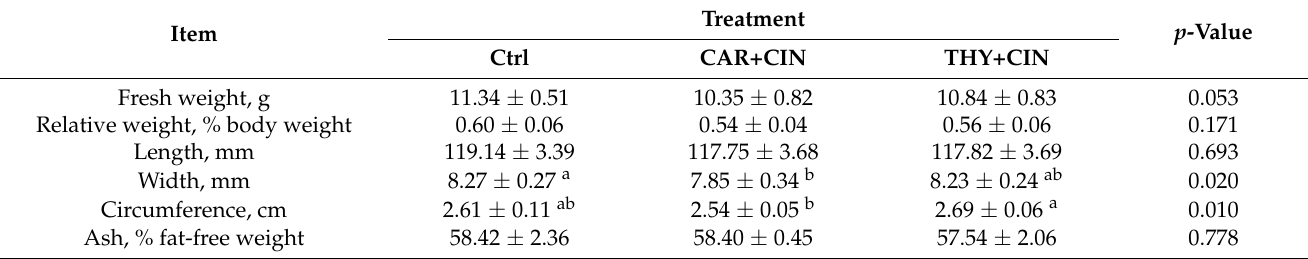
Table 3. Tibia bone properties of laying hens given to dietary essential oils supplementation.